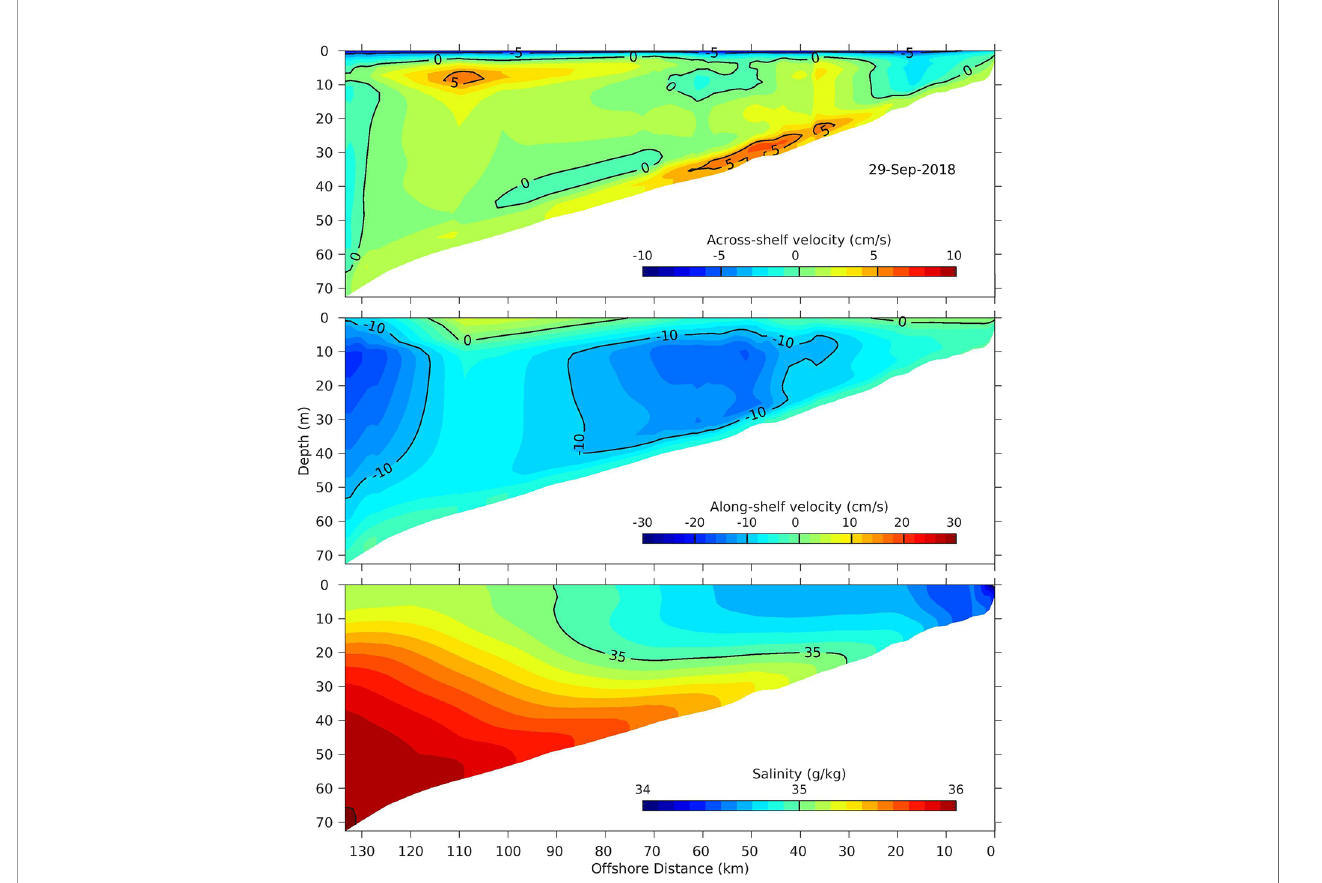
FIGURE 10 | Across-shelf sections sampled offshore from Sarasota, FL on September 29, 2018 from a West Florida Coastal Ocean Model simulation. From top to bottom are the across-shelf component of velocity, the along-shelf component of velocity and salinity, with contour intervals and units provided by the color bars in each